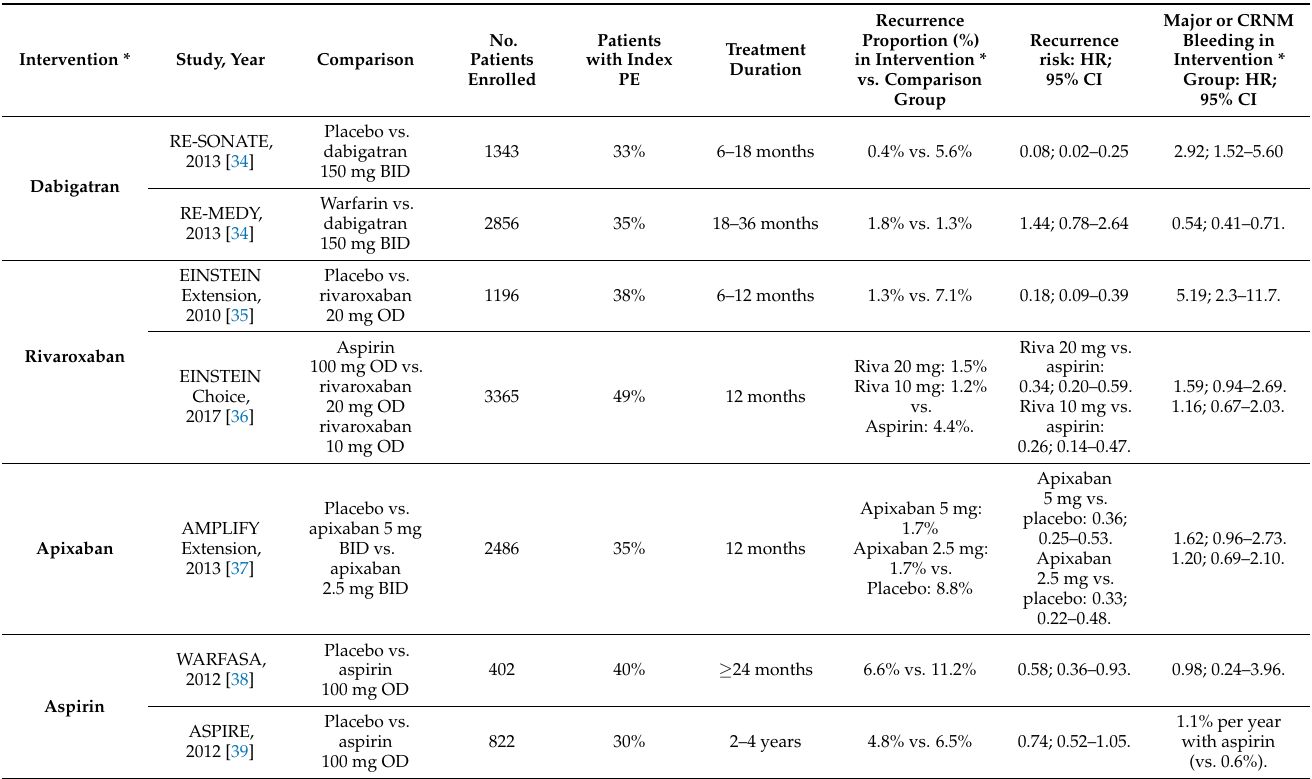
Table 1. Characteristics of studies on extended anticoagulation after incident VTE (adapted from Albertsen et